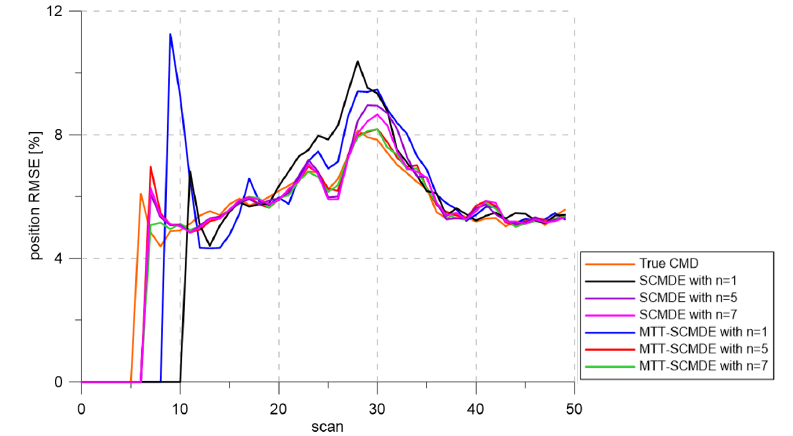
Figure 14. Position RMSE.